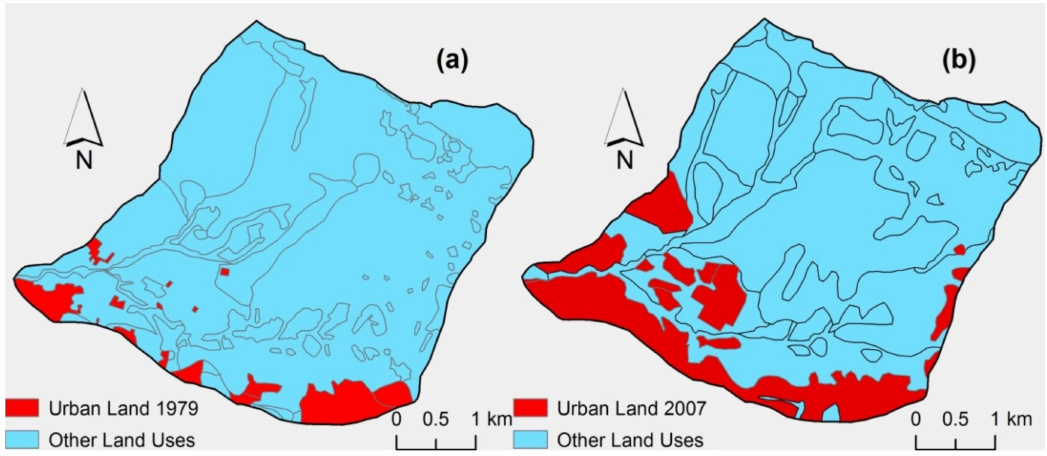
Figure 3. Land uses for the years 1979 ( a ) and 2007 ( b ).